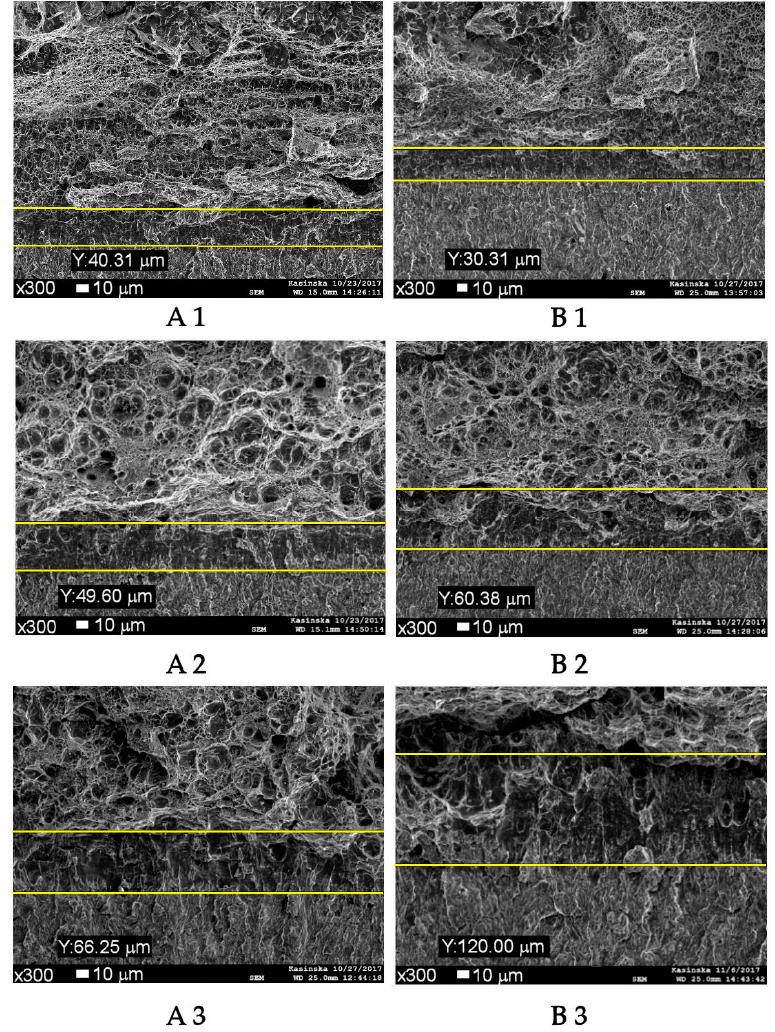
Figure 10. Images of fracture surfaces under the notch bottom with visible stretch zones.